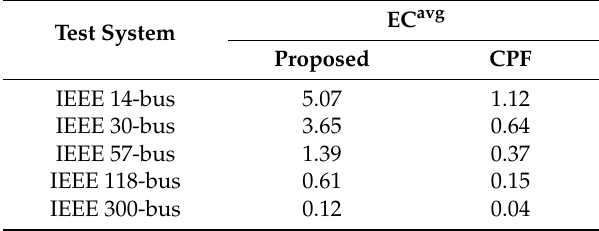
Table 5. Comparison of the results in terms of EC avg for the considered test systems.